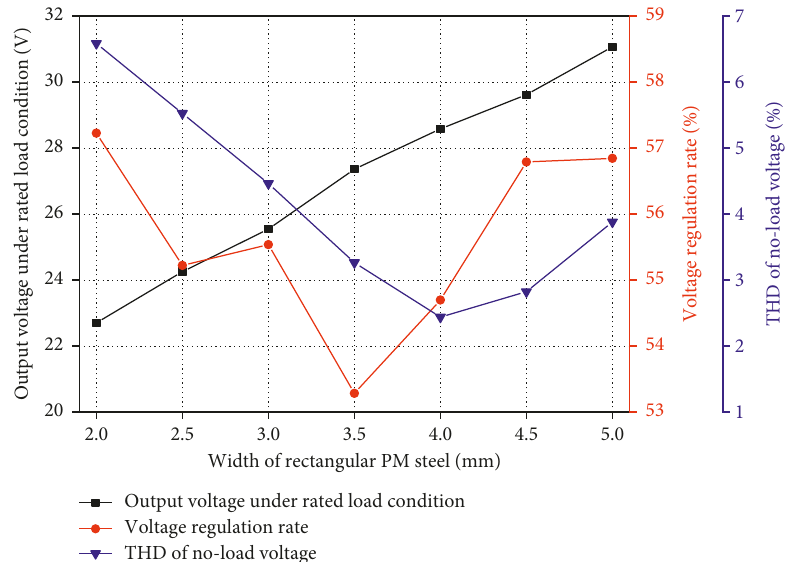
Figure 17: Variation curves of generator output performance with different widths of rectangular PM steel.